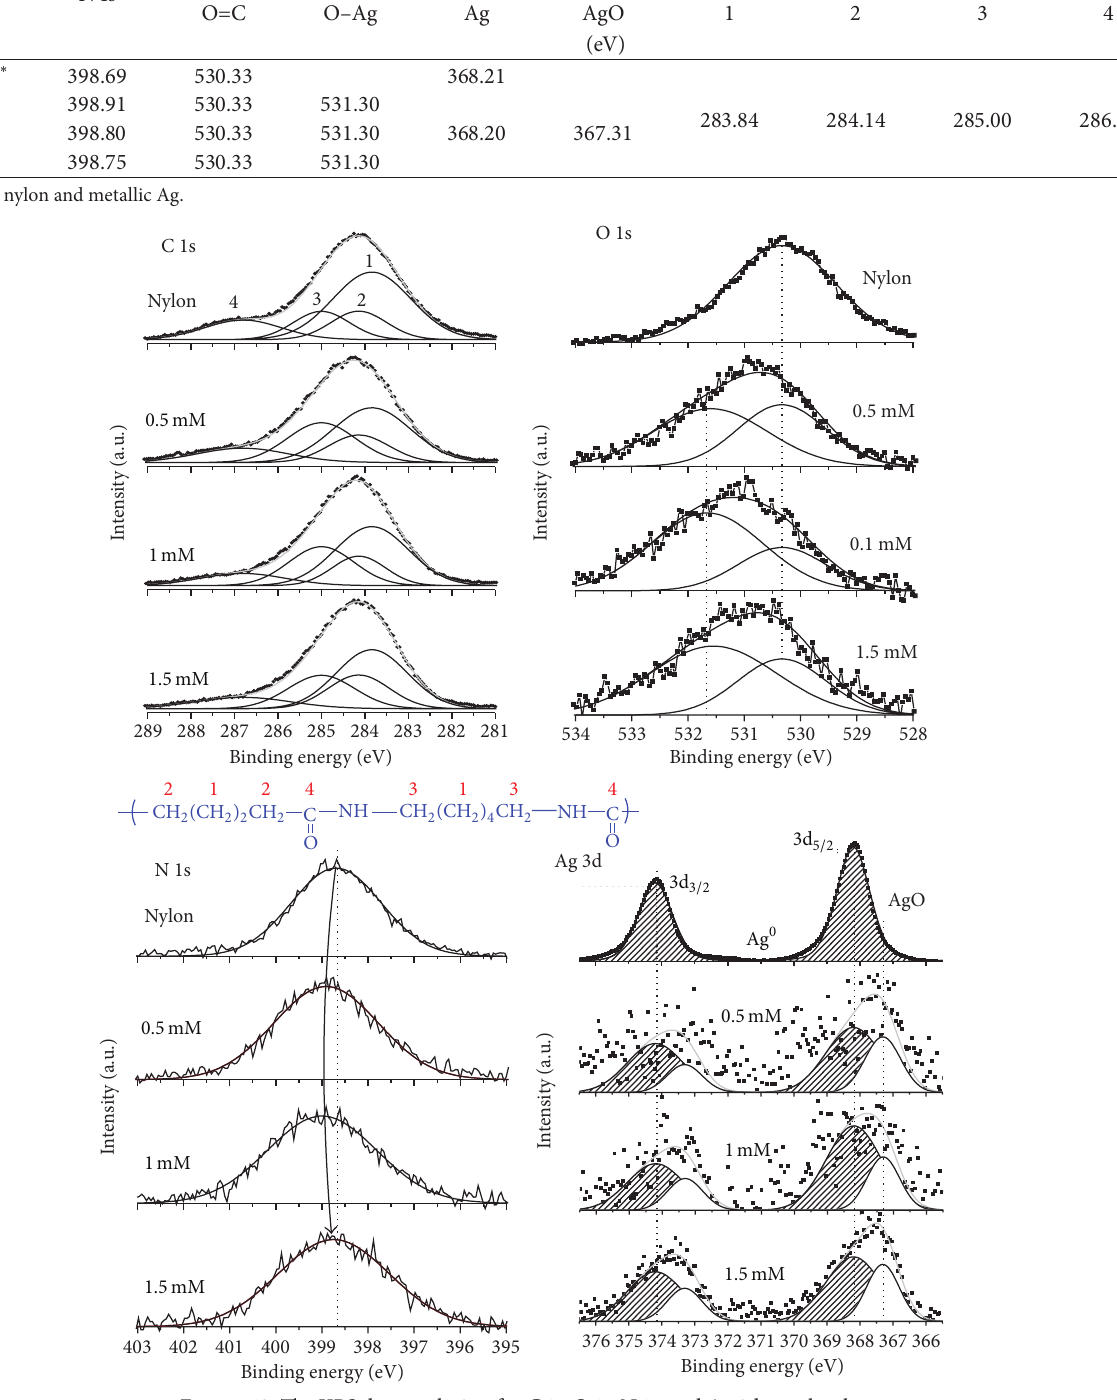
Figure 10: The XPS deconvolution for C 1s, O 1s, N 1s, and Ag 3d core